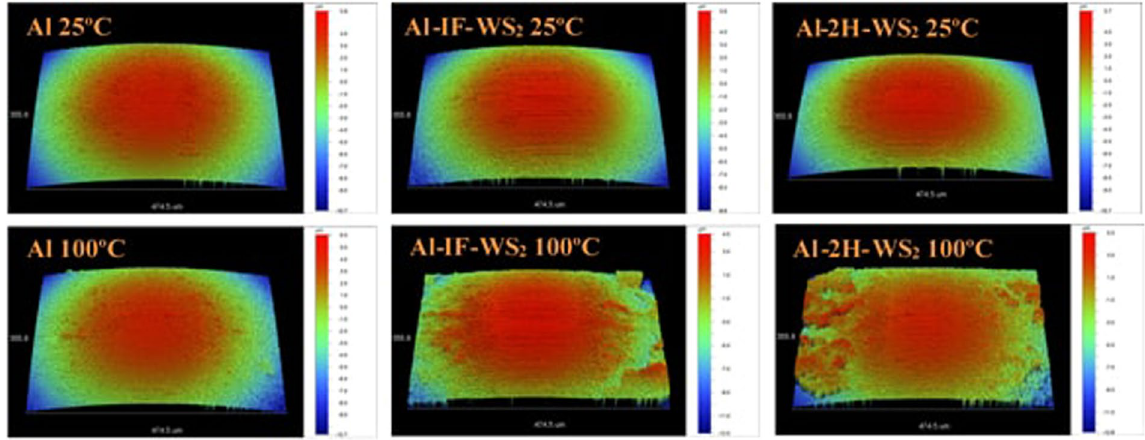
Figure 12. Profilometry images of the steel ball wear scars.